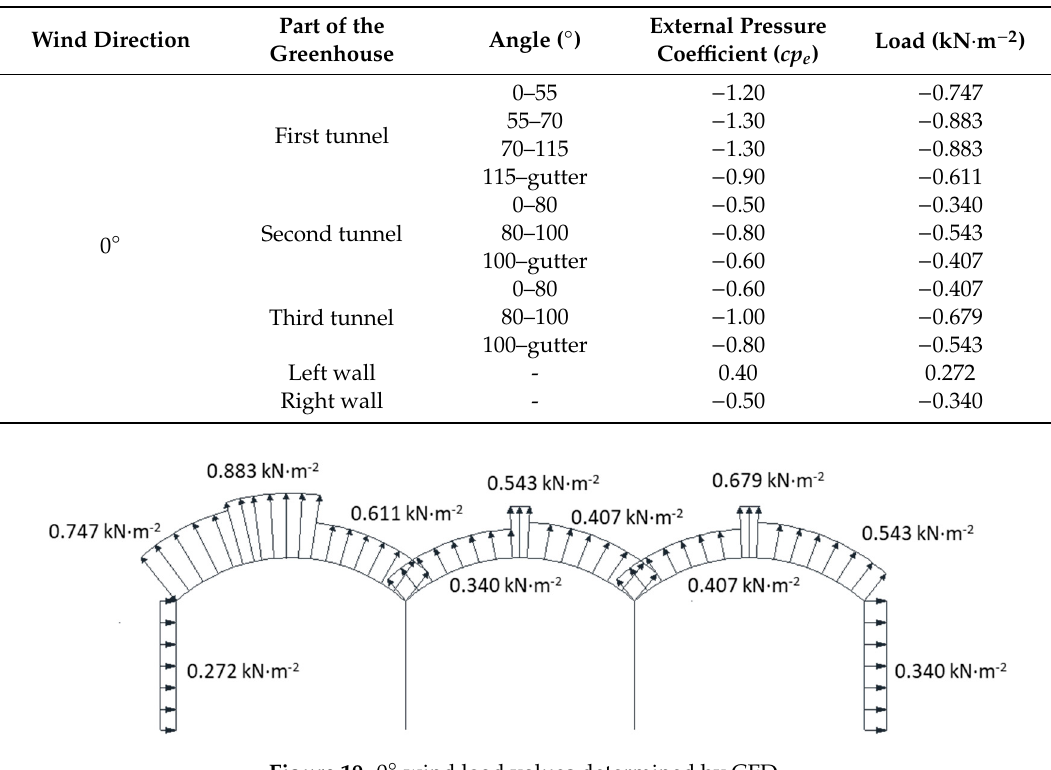
Figure 19. 0 ◦ wind load values determined by Figure 19. 0° wind load values determined by CFD.